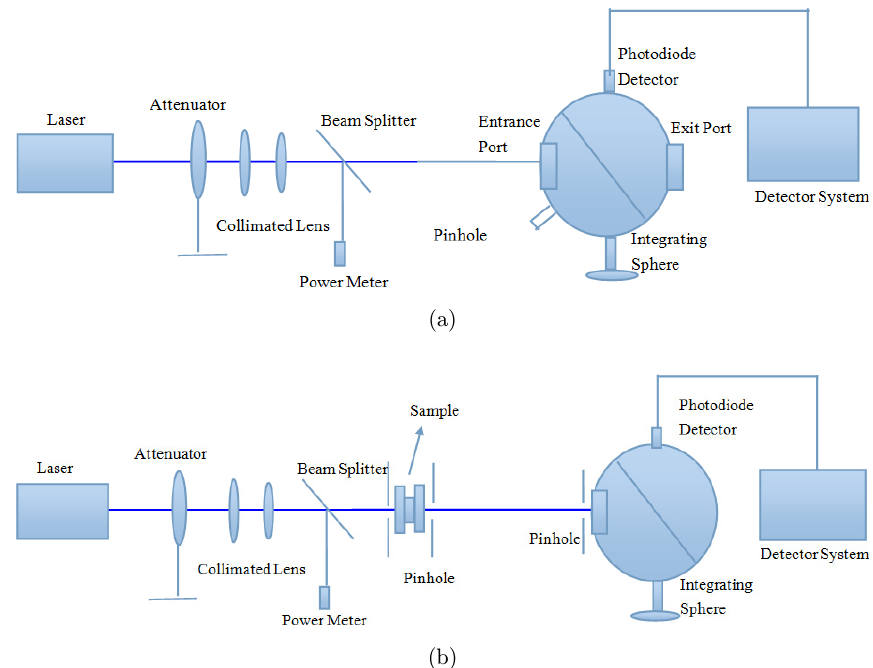
Fig. 2. Single integrating-sphere system for measurement of (a) absorption coe±cient and (b) attenuation